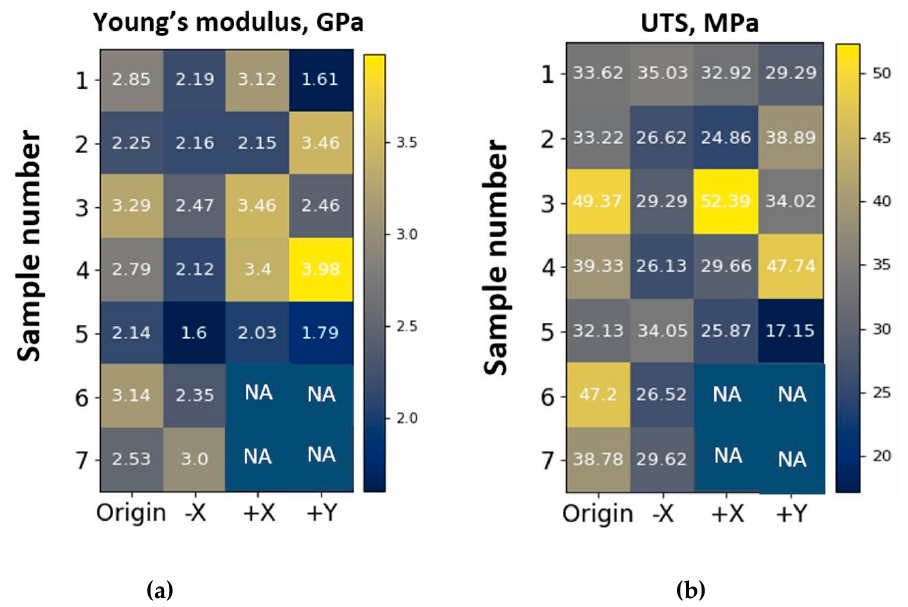
Figure 7. Young’s modulus and ultimate tensile strength of the printed specimens. ( a ) Young’s modulus (in GPa), ( b ) ultimate tensile strength (in MPa).